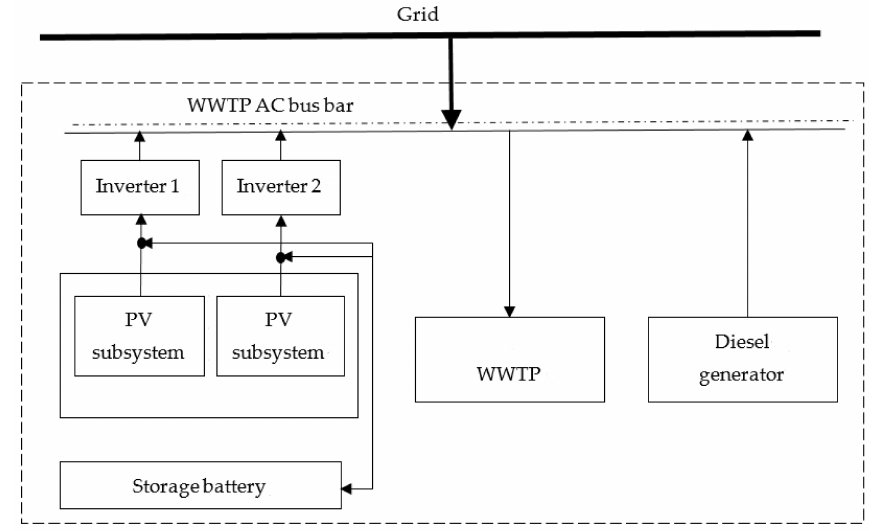
Figure 5. Schematic of a hybrid